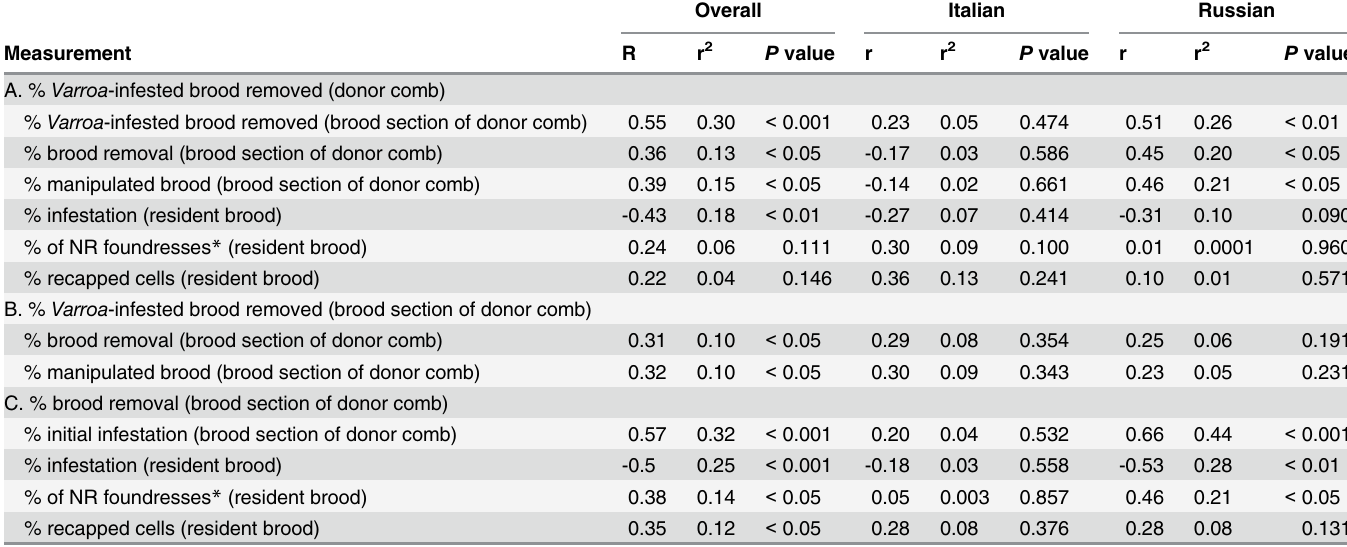
(Table 2). Interestingly, the average number of progeny and the average mite load were slightly Table 1. Results of the regression analyses relating percentages of Varroa -infested brood removed for whole comb and brood section of donor frames, and brood removal of brood section to different measurements related to hygiene. Overall Italian Russian Measurement